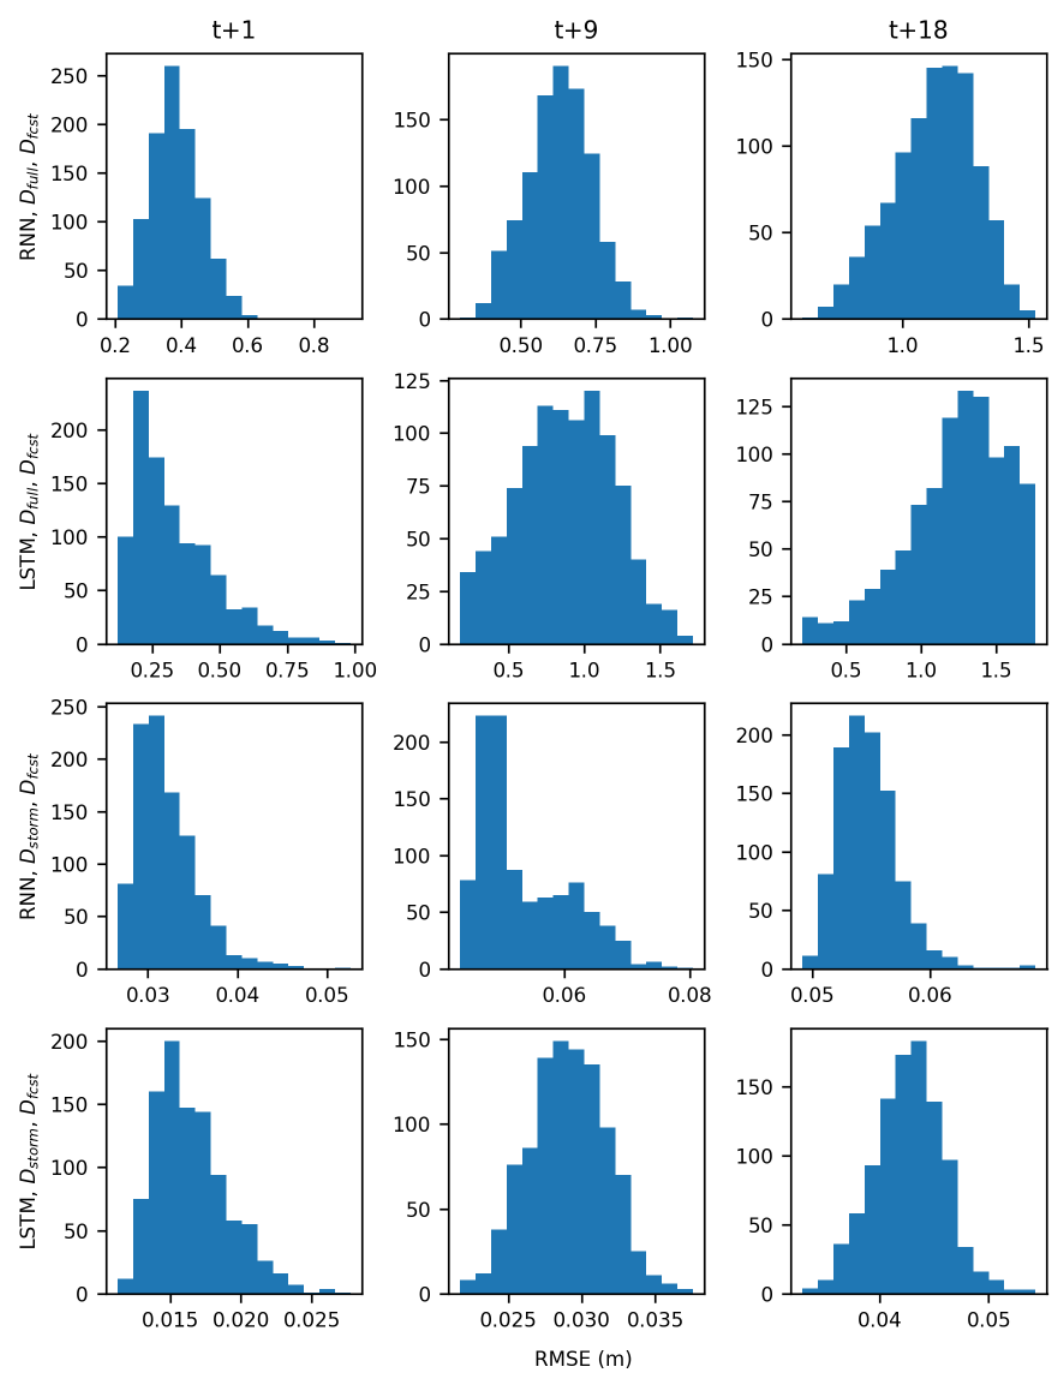
Figure A14. RMSE distributions for GW7 using forecast input data. Columns represent the forecast horizons t + 1, t + 9, and t + 18. Rows are specified as model type, training data, and testing data.